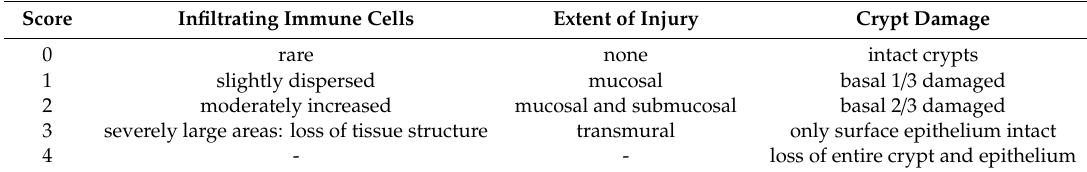
Table 2. Histology scoring system.